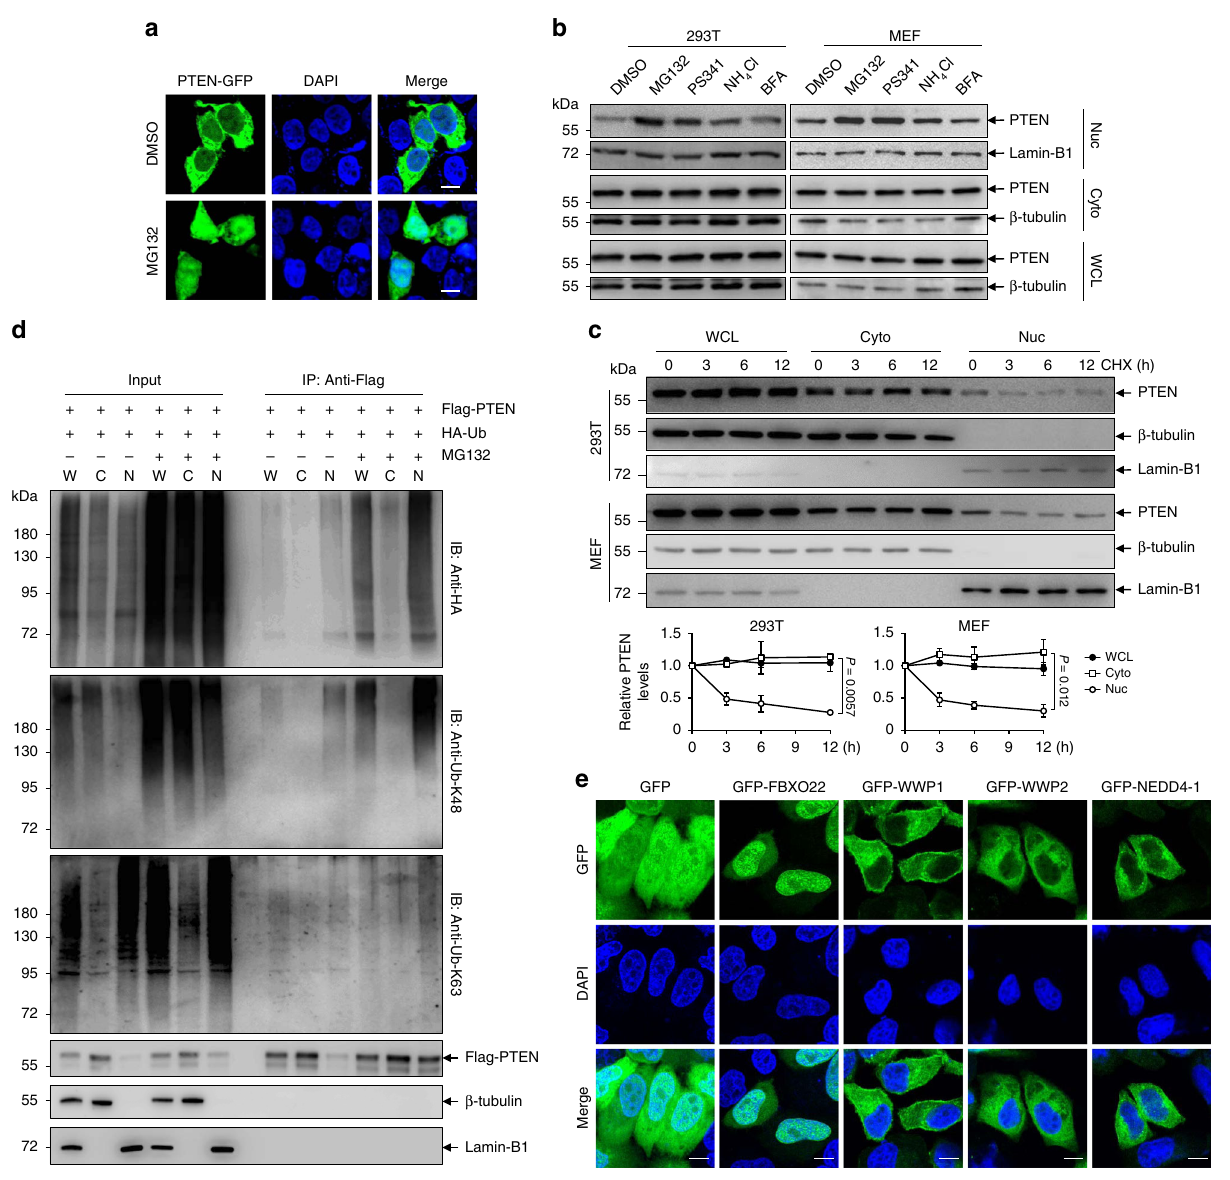
Fig. 1 Nuclear PTEN is sensitive to ubiquitin-mediated proteasomal degradation. a A clonally derived 293T PTEN knockout cell line (293T-PTEN KO ) was transfected with PTEN-GFP for 8 h, followed by treatment with 10 μ M MG132 or DMSO for 6 h, stained with DAPI, and imaged with confocal microscopy. Scale bar represents 10 μ m. b Western blots of indicated proteins in cytoplasmic (Cyto) and nuclear (Nuc) fractions as well as whole-cell lysates (WCL) of 293T cells and MEF treated with DMSO, 10 μ M MG132, 10 μ M PS341, 10 mM NH 4 Cl and 10 μ M BFA for 8 h. β -tubulin and Lamin-B1, respectively, serve as cytoplasmic and nuclear markers. c Western blots of indicated proteins (top) and quanti fi cation of relative PTEN levels (bottom) in cytoplasmicand nuclear fractions as well as whole-cell lysates of 293T cells and MEF treated with 50 μ g/ml CHX for indicated times. Quanti fi cation of protein bands was performed using ImageJ software. d 293T cells transfected with the indicated plasmids were treated with 10 μ M MG132 or DMSO for 6 h, harvested and submitted to subcellular fractionation, followed by in vivo ubiquitination assay and western blot analysis for indicated proteins. C cytoplasm; N nucleus; W whole-cell lysates. e Representative images of GFP-tagged FBXO22, NEDD4-1, WWP2, and WWP1 transfected in Hela cells with re-staining of DAPI. Scale bar represents 10 μ m. The experiments shown in a , b , d , and e were repeated three times with similar results, and the results of one representative experiment are shown. The data in panel c are presented as the mean ± SEM, n = 3 independent experiments, statistical signi fi cance was determined by two-way ANOVA. Source data are provided as a Source Data fi fi rstly tested the possible involvement of NEDD4-1 and WWP2, transfected with plasmid encoding Flag-tagged PTEN along with empty vector, followed by af fi nity puri fi cation using an anti-Flag two known proto-oncogenic ubiquitin ligases for PTEN antibody, and the bound proteins were analyzed by liquid chro- degradation 16,41 . However, both enzymes showed predominant cytoplasmic localization (Supplementary Fig. 1c), and their matography with tandem mass spectrometry (LC – MS/MS). We knockdown by shRNA increased total and cytoplasmic but not noticed that FBXO22 was the only ubiquitin ligase that presented nuclear PTEN in 293T and SW620 cells (Supplementary Fig. 1d), in the PTEN immunoprecipitate (Supplementary Data 1). More suggesting that these two ligases did not contribute to the degradation of nuclear PTEN. Thus, 293T cells were transiently FBXO22 was predominantly nuclear localized in Hela cells, in